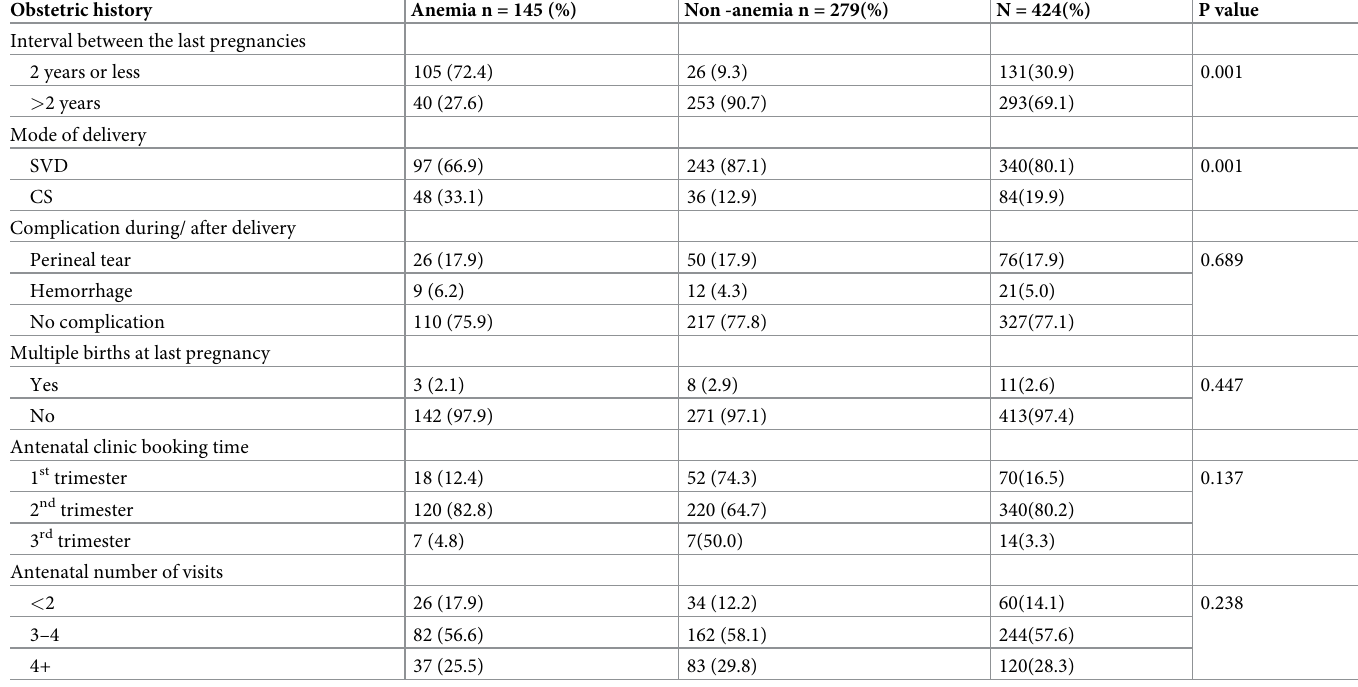
Table 2. Relationship between anemia and obstetric characteristics of women who attended Reproductive and Child Health clinics at Mnazi Mmoja, Kigamboni and Magomeni Health Centers (N = 424). Obstetric history